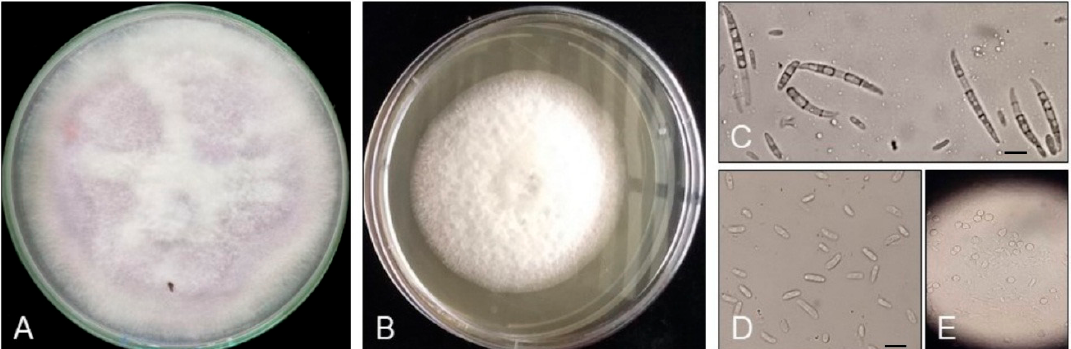
Figure 2. Morphological characteristics of the fungus isolated from banana orchards of the Chitwan and Nawalparasi districts. ( A ) Purple shades of Fusarium oxysporum f. sp. cubense ( Foc ) on PDA medium; ( B ) white shades of Foc on PDA medium; ( C ) macroconidia of Foc ; ( D ) microconidia of Foc ; and ( E ) chlamydospores of Foc . All scale bars 10 µm.